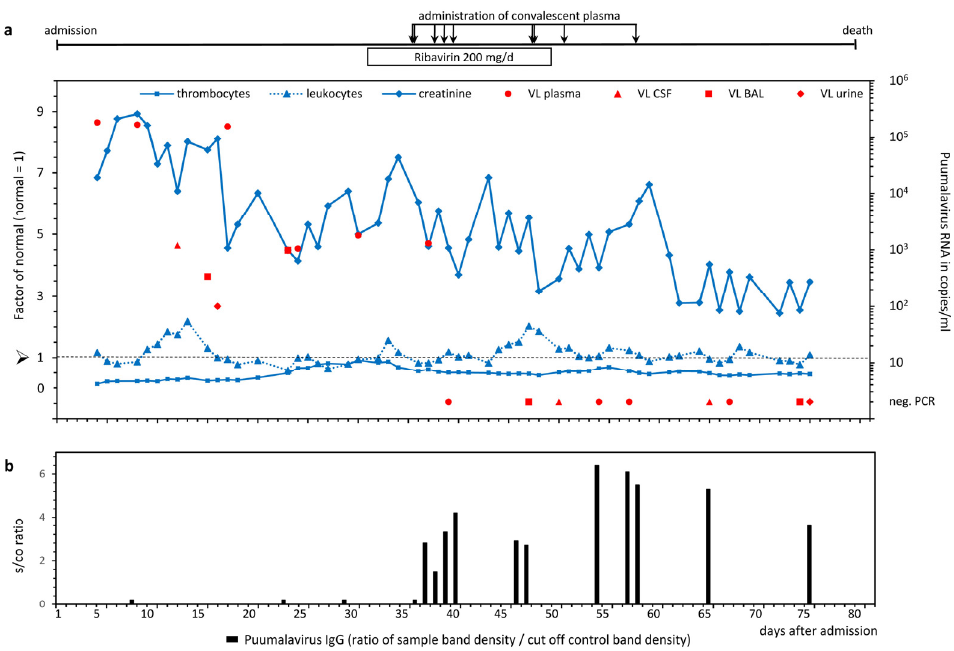
Figure 1. ( a ) Course of PUUV RNA concentration, and thrombocyte, leukocyte, and creatinine levels. Viral load (VL) in different compartments (cerebrospinal fluid [CSF], bronchial lavage [BAL], and urine) was quantified by real-time qPCR with a limit of detection of 100 PUUV RNA copies/mL. Values of thrombocytes, leukocytes, and creatinine in serum are depicted as factors of the normal mean value; the normal mean value of the reference range was set to 1 (dotted line) for each parameter. Treatment with ribavirin and administration of convalescent plasma are shown on top of panel ( a ). In panel ( b ), the detectable amount of anti-PUUV IgG in response to the passive immunization by PUUV immunoglobulin transfer is depicted. The four symbols between day 8 and 36 indicate negative immunoblots in the patient’s serum before administration of convalescent plasma.